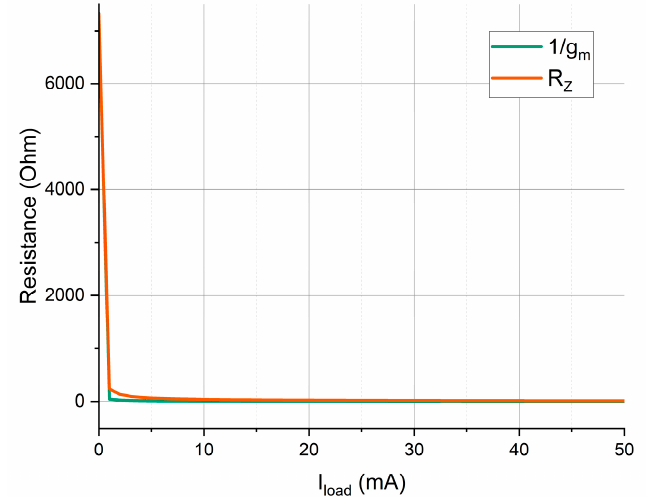
Figure 7. Comparison of R Z and 1/g m in the simulation.